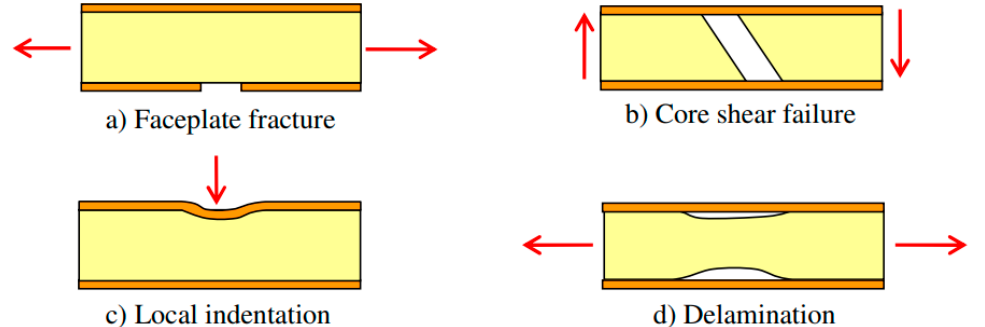
Figure 17. Failure modes of sandwich panels in SPIF (reproduced with permission from [272]; copyright© 2021 Elsevier B.V.).